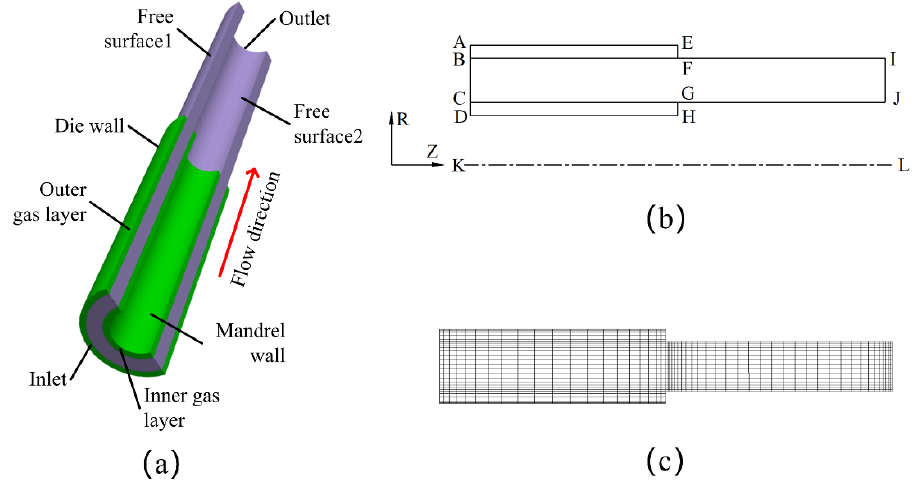
Figure 1. Geometric model and finite element model of the process of double-layer gas-assisted extrusion of plastic micro-tubes. ( a ) Geometric model of the flow process of melt in the die; ( b ) Simplified two-dimensional axisymmetric geometric model; ( c ) Finite element mesh model.